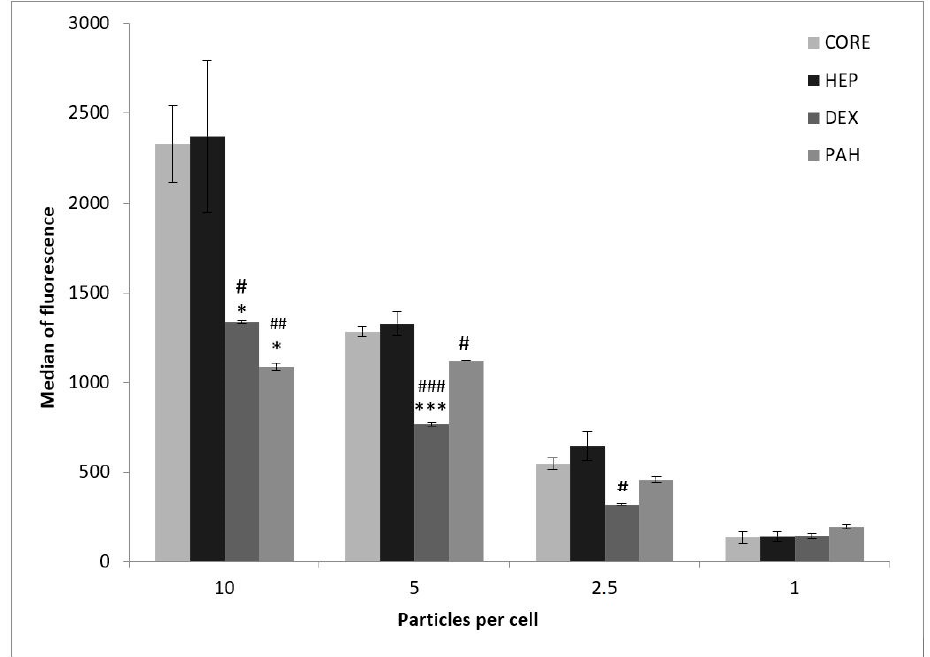
Figure 8. Intracellular presence of particles with outer-layers composed of dextran (DEX), heparin (HEP), poly(allylamine hydrochloride) (PAH) and nonmodified conjugate cores (CORE) labeled by fluorescent coumarin-6 in RAW 264.7 cells. Cells were incubated with the particles for 2 h before flow cytometry assay. The one-way ANOVA test followed by Tukey’s test was used to compare the effectiveness of internalization of nonmodified conjugate core with particles in the same concentration (*** p < 0.001, ** p < 0.01, and * p < 0.05) and compare the effectiveness of internalization heparin coated particle with other particles in the same concentration (### p < 0.001, ## p < 0.01, and # p < 0.05).